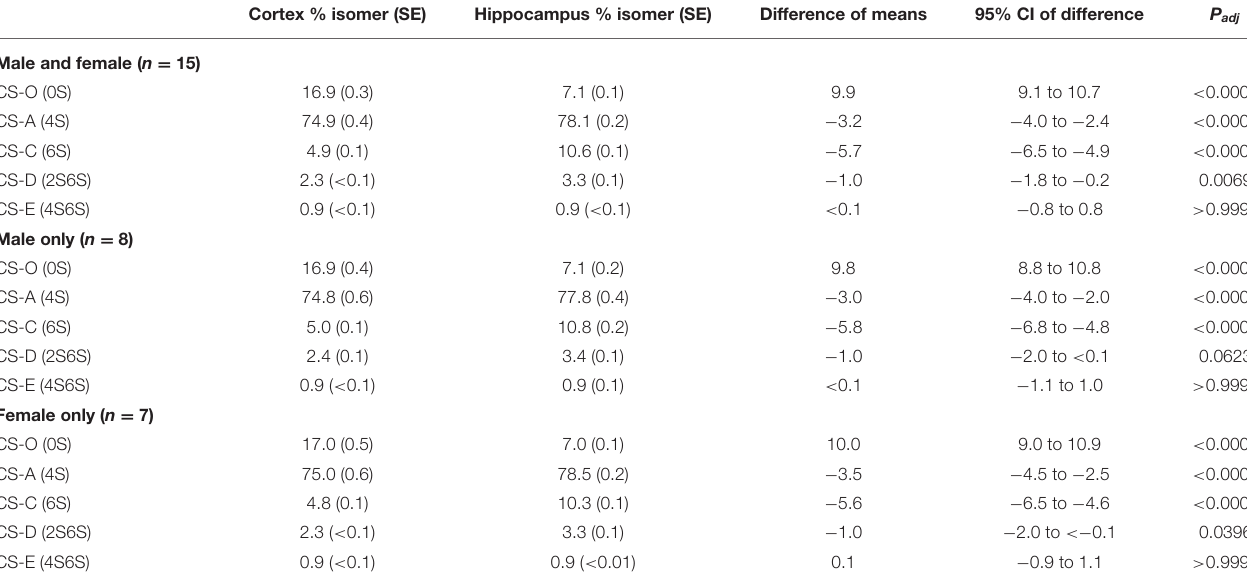
TABLE 3 | Interregional changes in CS-GAG sulfation patterns in mouse